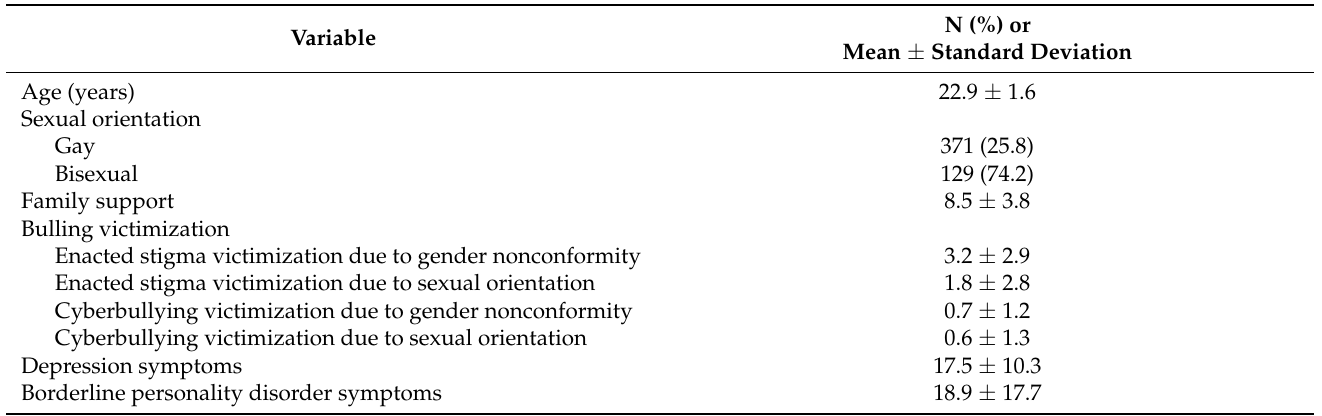
Table 1. Characteristics of Participants (N = 500).